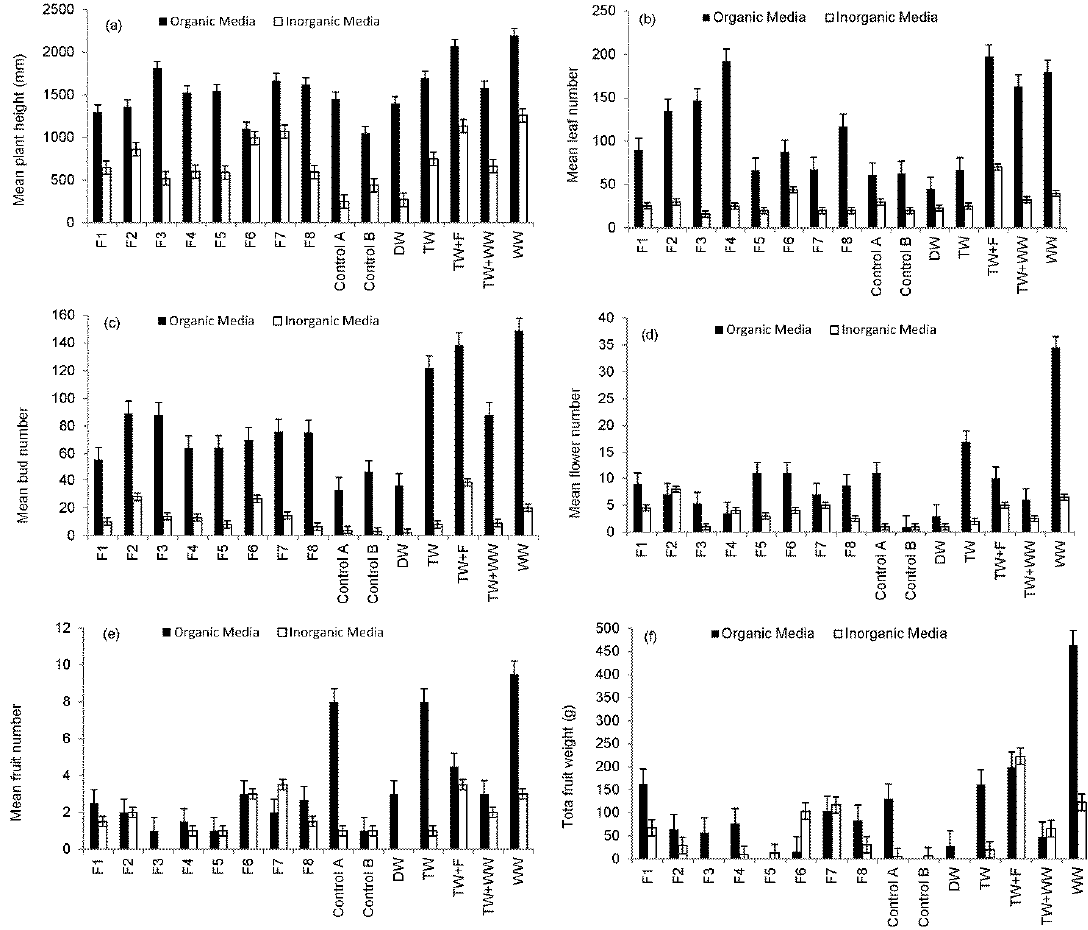
Figure 3. Comparison in growth of plants grown in different media and subjected to different irrigation water types (harvest between 20 January and 25 September 2014): ( a ) mean plant height; ( b ) mean leaf number; ( c ) mean bud number; ( d ) mean flower number; ( e ) mean fruit number; and ( f ) mean fruit weight.